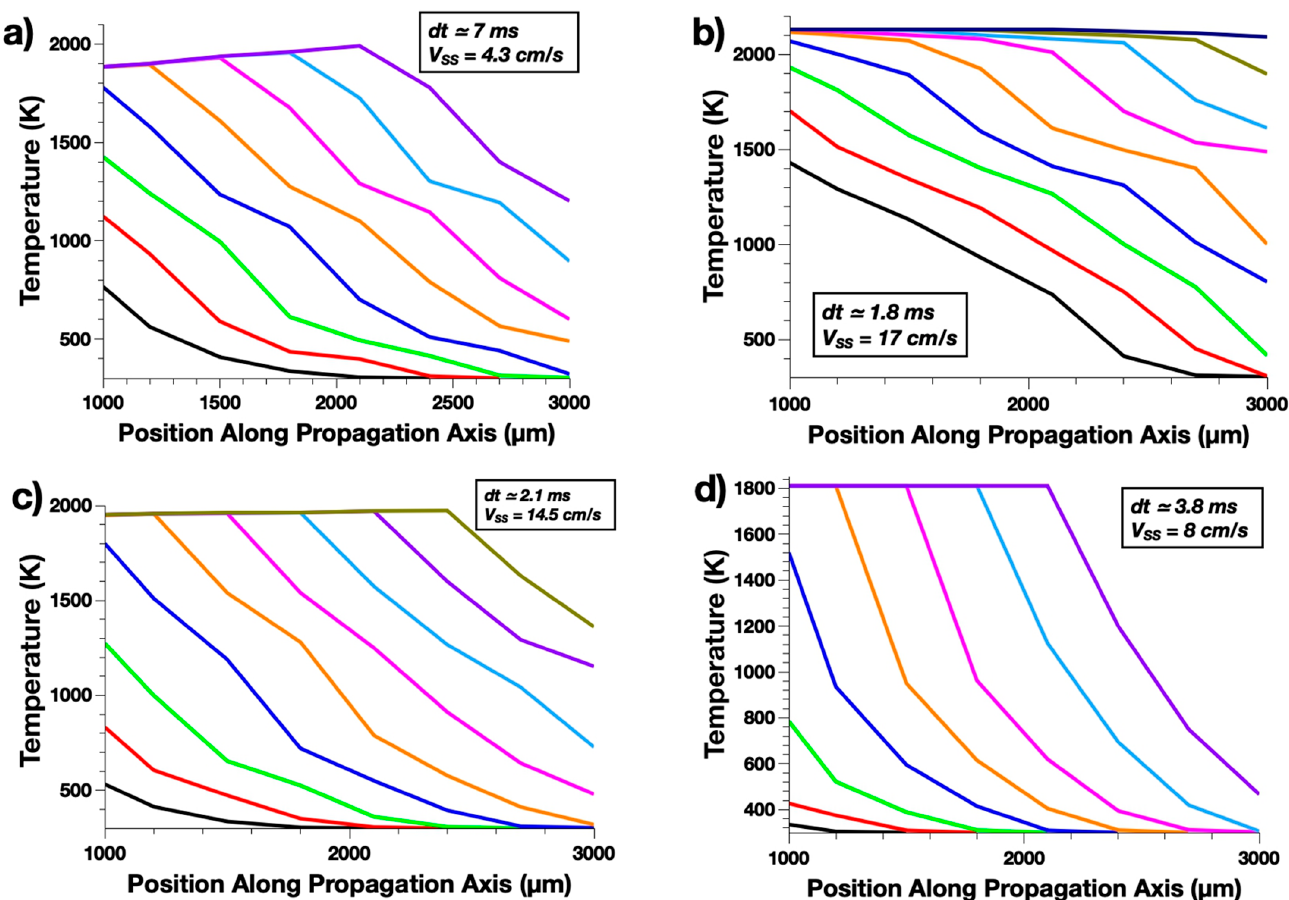
Figure 4. Temperature profiles taken at regular time intervals dt and calculated burn rate V SS for: ( a ) B/CuO, ( b ) B/Fe 2 O 3 , ( c ) B/WO 3 , and ( d ) B/Pb 3 O 4 systems at ξ = 1.0 with 80-nm boron particles.